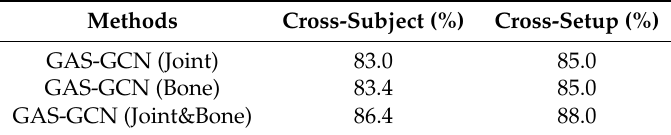
Table 6. The experimental results on NTU-RGB + D 120 dataset. As far as we know, there are no other published results of recent methods on this dataset due to that the dataset has just been